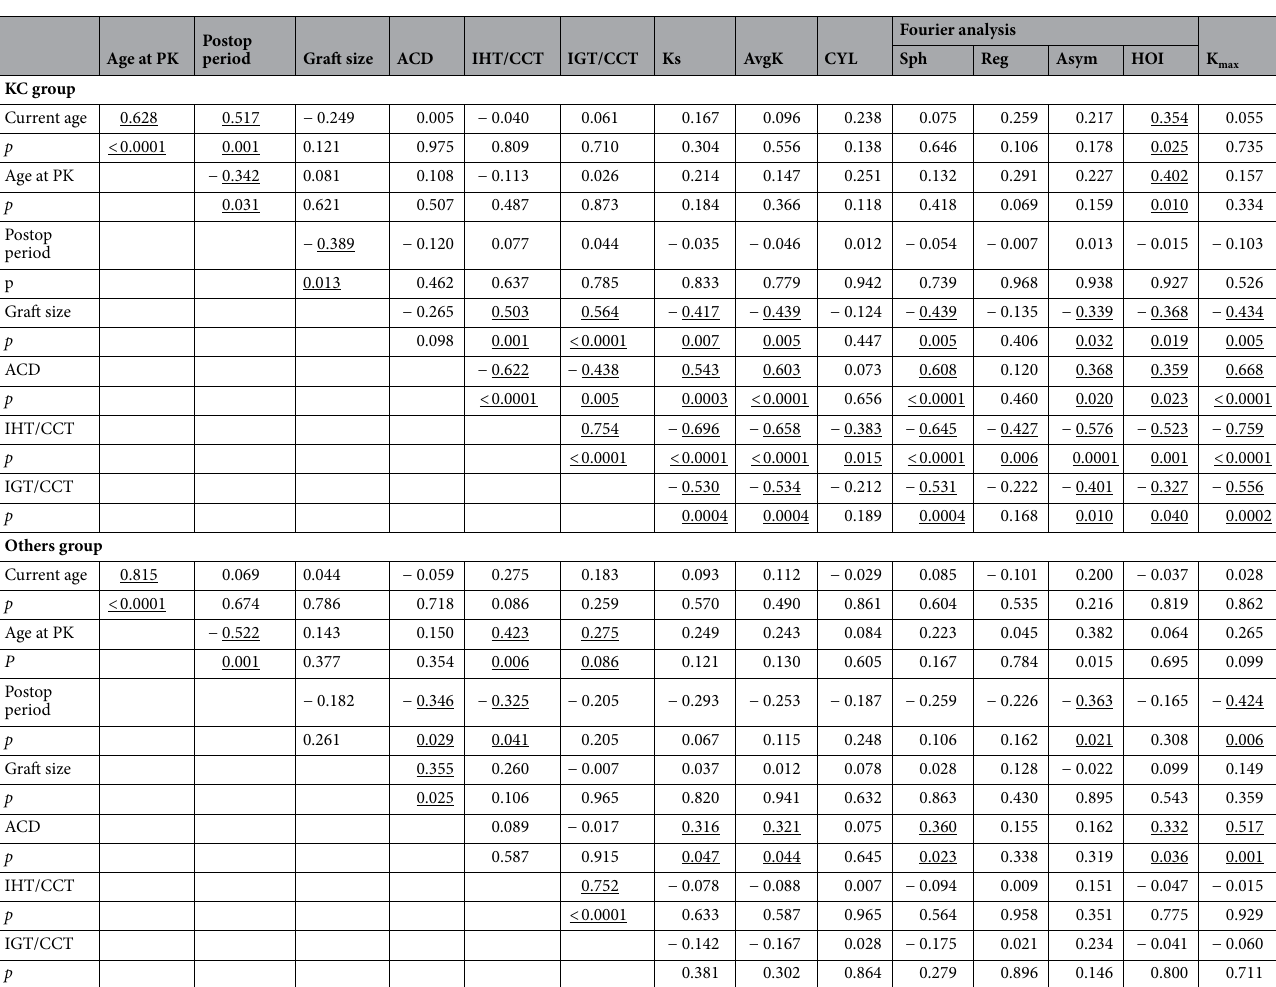
Table 2. Correlation of each parameter in the KC and others groups: Pearson correlation coefficients. Underline values indicate p < 0.05. KC keratoconus, PK penetrating keratoplasty, Postop period